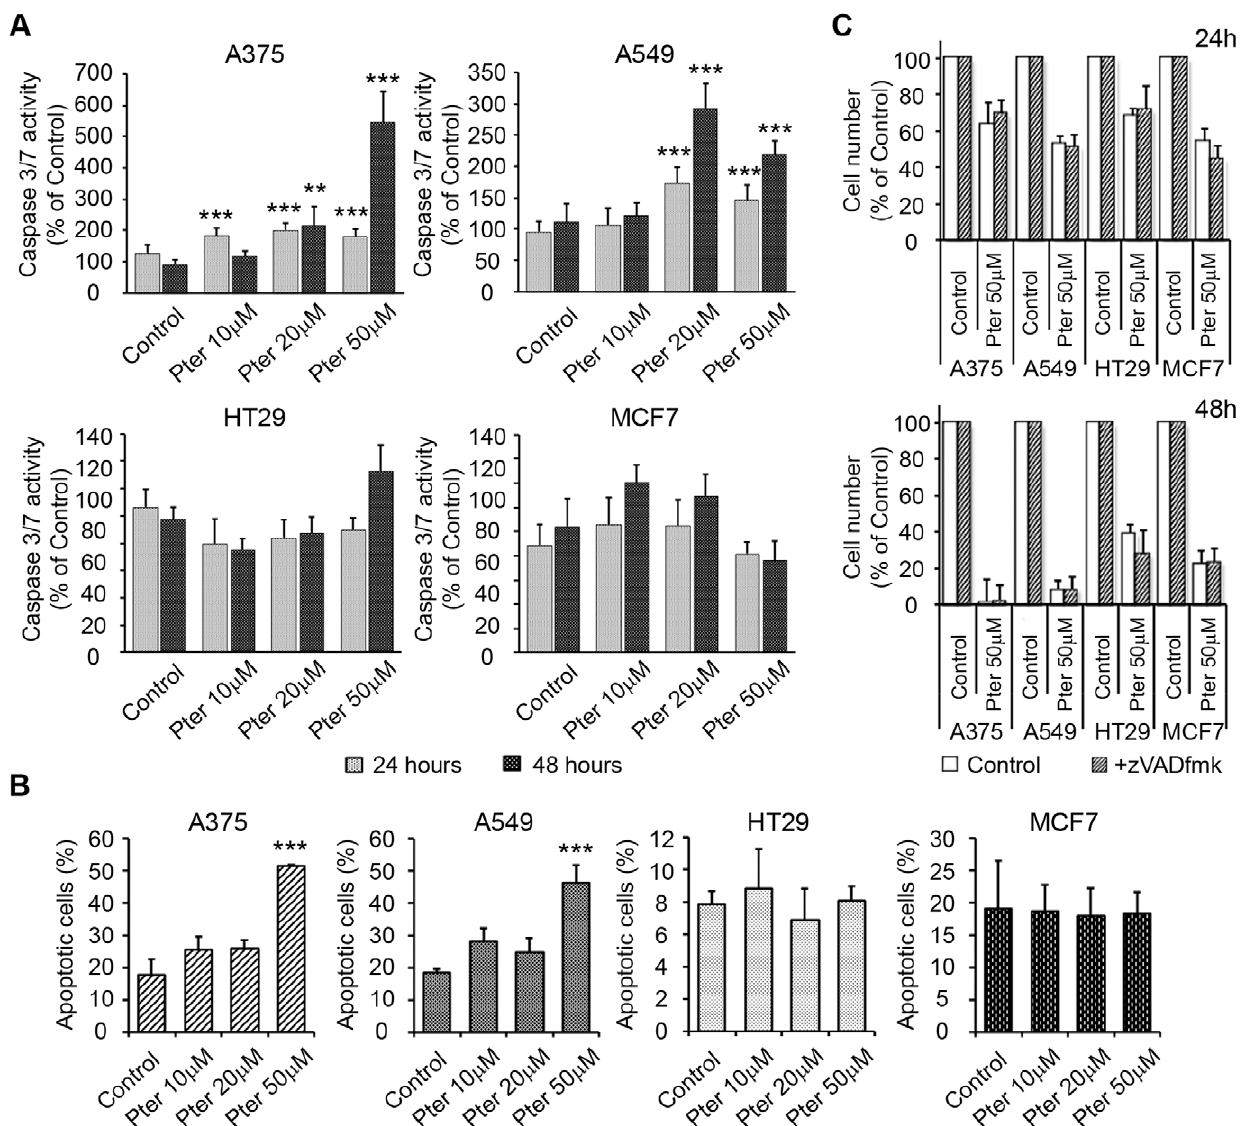
Figure 3. Pter induces caspase-independent cell death. A) Caspase-3/7 (DEVDase) activities were evaluated 24 and 48 h after addition of Pter. Results are expressed as a relative index of fluorescence 6 SD (n=3) when compared with control (100%). The results were statistically analyzed by ANOVA and contrasted by the Tukey test (*p , 0.001; **p , 0.01 Vs. Control). B) Induction of apoptosis was assayed by staining with Annexin V. The total percentage of Annexin V-positive cells was determined by flow cytometry 48 h after treatment with DMSO or with increasing concentrations